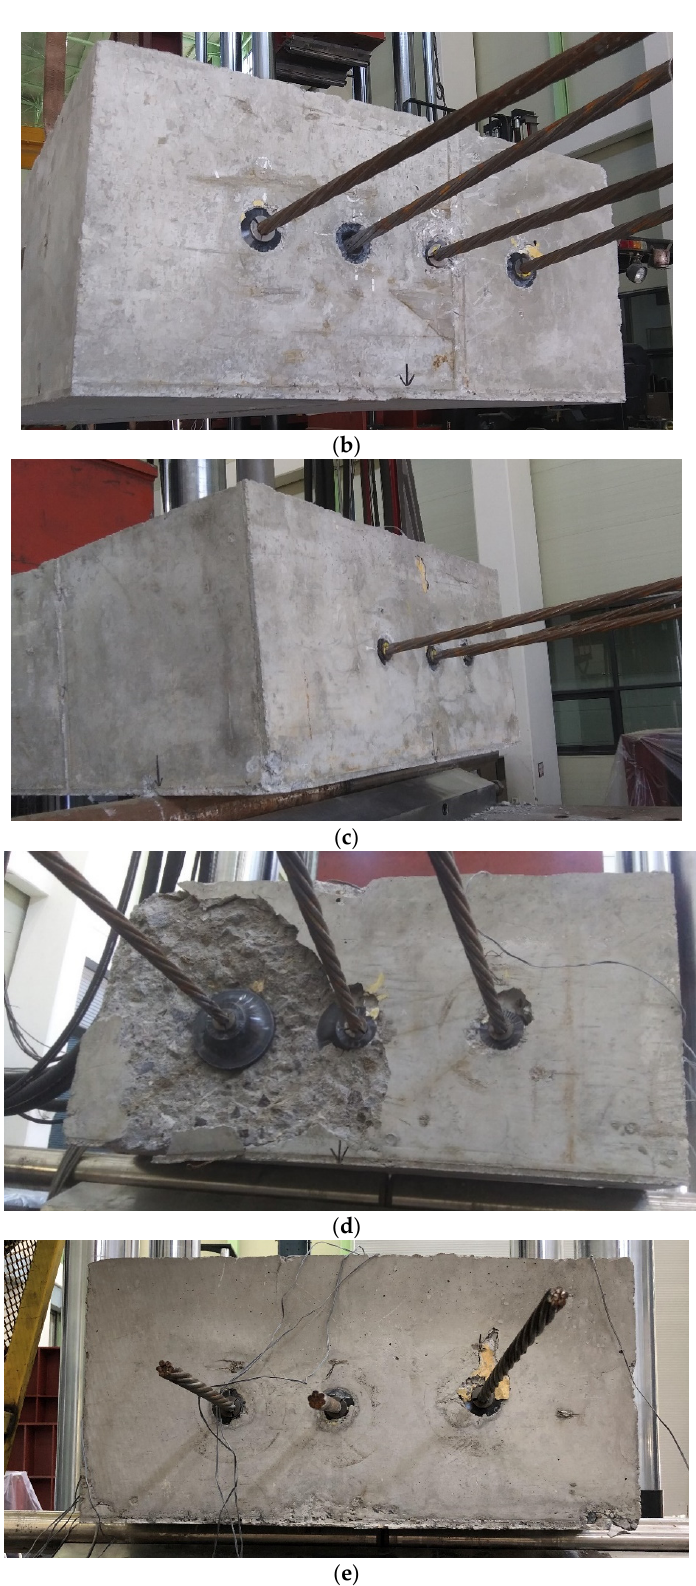
Figure 11. Cracking and failure of specimens ( a ) RH-4; ( b ) CH-4; ( c ) CH-3; ( d ) CS1-3; ( e ) CS2-3.